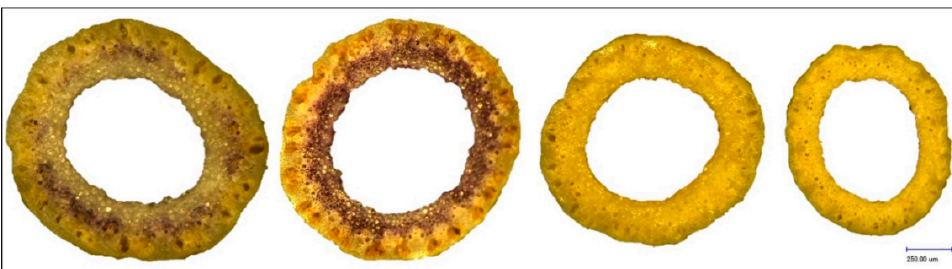
Figure 5. Thickness of culm tissues of selected HEB-25 lines and Barke as reference. From left to right: HEB_23_037, HEB_20_017, Barke,